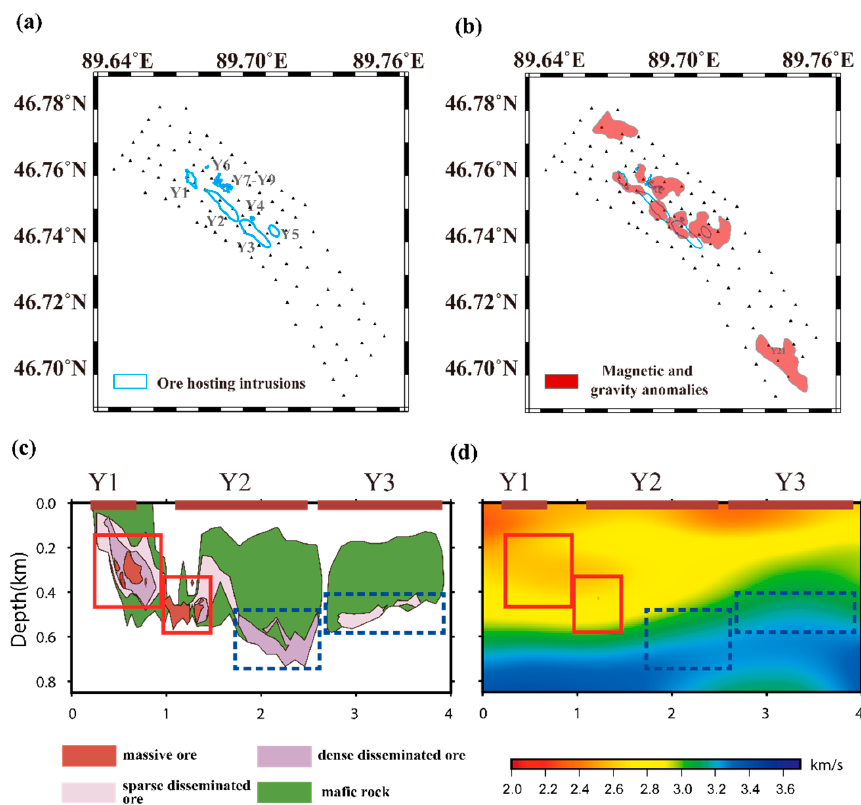
Figure 11. Potential of geophysical models in aiding deep prospecting work. ( a ) Surface distribution of orebodies. ( b ) Magnetic and gravity anomalies from [5]. ( c ) Locations of intrusions along the NW–SE profile across the three main ore bodies Y1 to Y3. The shapes of the intrusions were determined by drilling data from [5]. Red boxes are highly mineralized intrusions and blue boxes are much less mineralized. ( d ) Velocity model from ambient noise inversion.